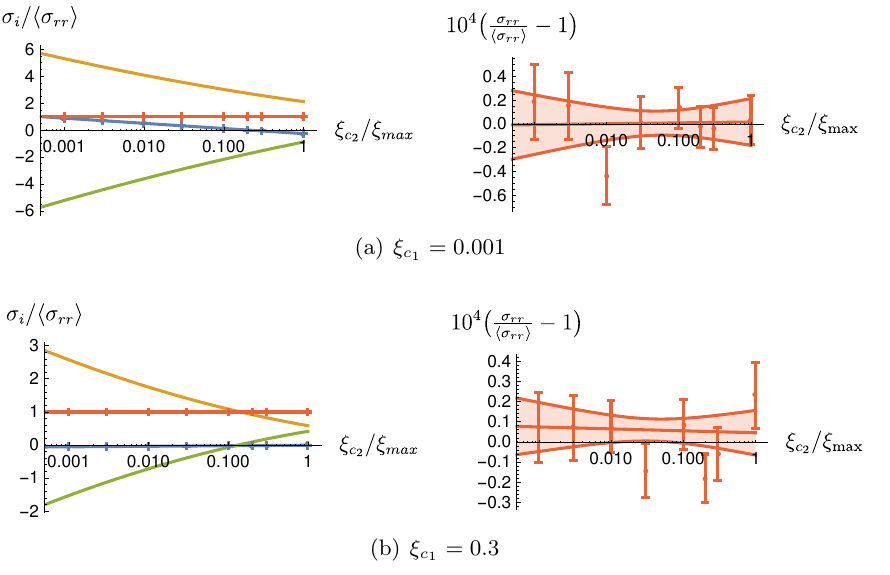
( I ( (cid:24) c ; (cid:24) c ) + I ( (cid:24) c ; (cid:24) c )) contribution 2 1 2 1 2